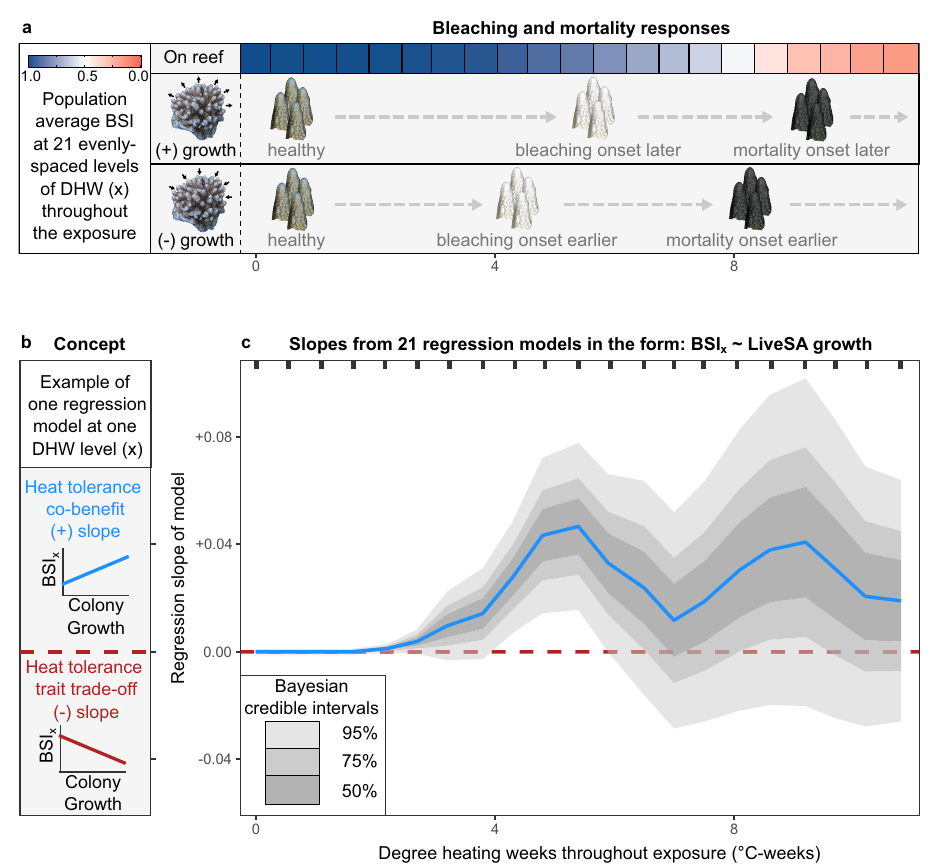
Fig. 3 Progression of bleaching and mortality throughout heat stress exposure as a function of donor colony growth rate. The association between corrected annual colony growth in terms of live surface area (LiveSA from 3D models on the reef) and acute bleaching survival responses (BSI) of colony fragments in heat stress tanks. a Progression of bleaching and mortality responses (colour bar) is shown at 21 evenly spaced degree heating week (DHW) levels (x) on the x -axis. Fragments from positive-growth colonies take longer to bleach and die than those from negative-growth colonies. b Conceptual diagram linking the slope of one BSI-growth regression model (for all colonies with available data) at a single DHW level (x) to positive trait correlations (positive slope) or trade-offs (negative slope). A slope of zero is shown by the dashed red line. c Progression of the relationship between colony growth and fragment BSI at 21 DHW levels (x, bold ticks on top), shown as the median slope (blue line) and the 50%, 75%, and 95% Bayesian credible intervals (grey shading) from posterior distributions of 21 regression